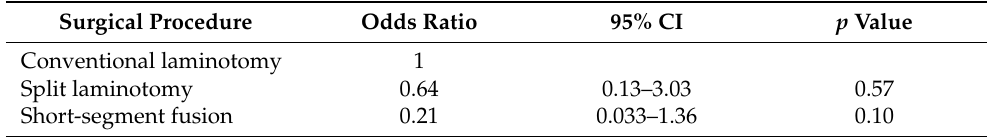
Table 5. Logistic regression analysis of the surgical procedure with JOA improvement score > 25% for patients with vacuum phenomenon at a lower segment and one distance from the segment adjacent to